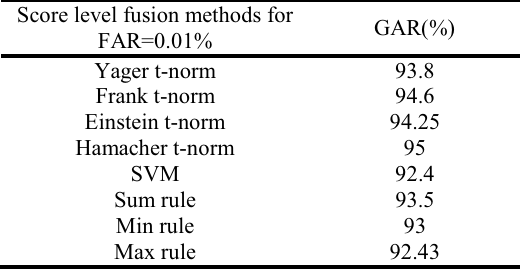
Tab.1. The performance comparison between different score level fusion methods Score level fusion methods for